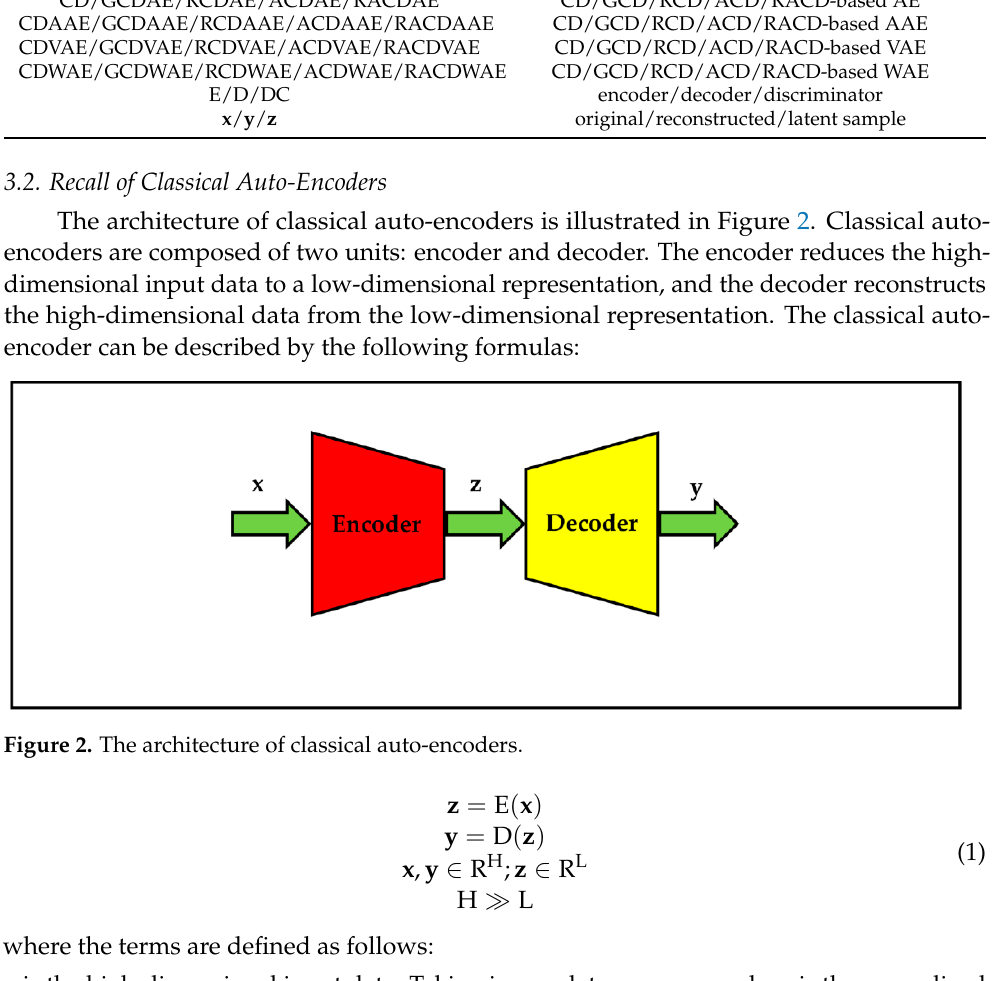
Table 2. Mathematical notations and abbreviations.